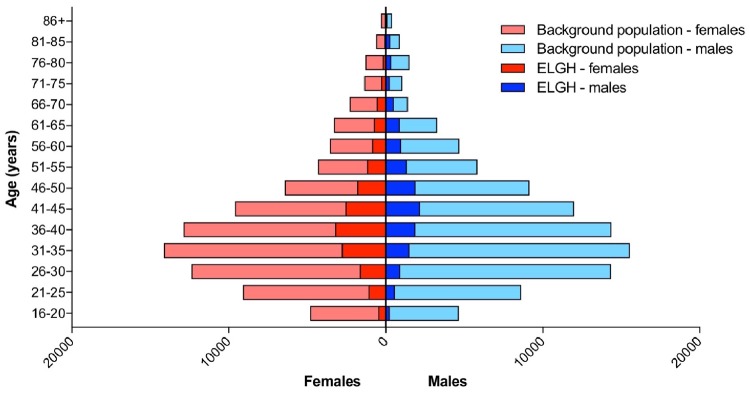
Population pyramid showing age and sex of ELGH volunteers (n = 29 370) versus the total population of British Bangladeshi and British Pakistani people (n = 152 564) in east London (all NHS GP-registered adults residing in the London Boroughs of City and Hackney, Newham, Tower Hamlets, Waltham Forest), aged ≥ 16 years.